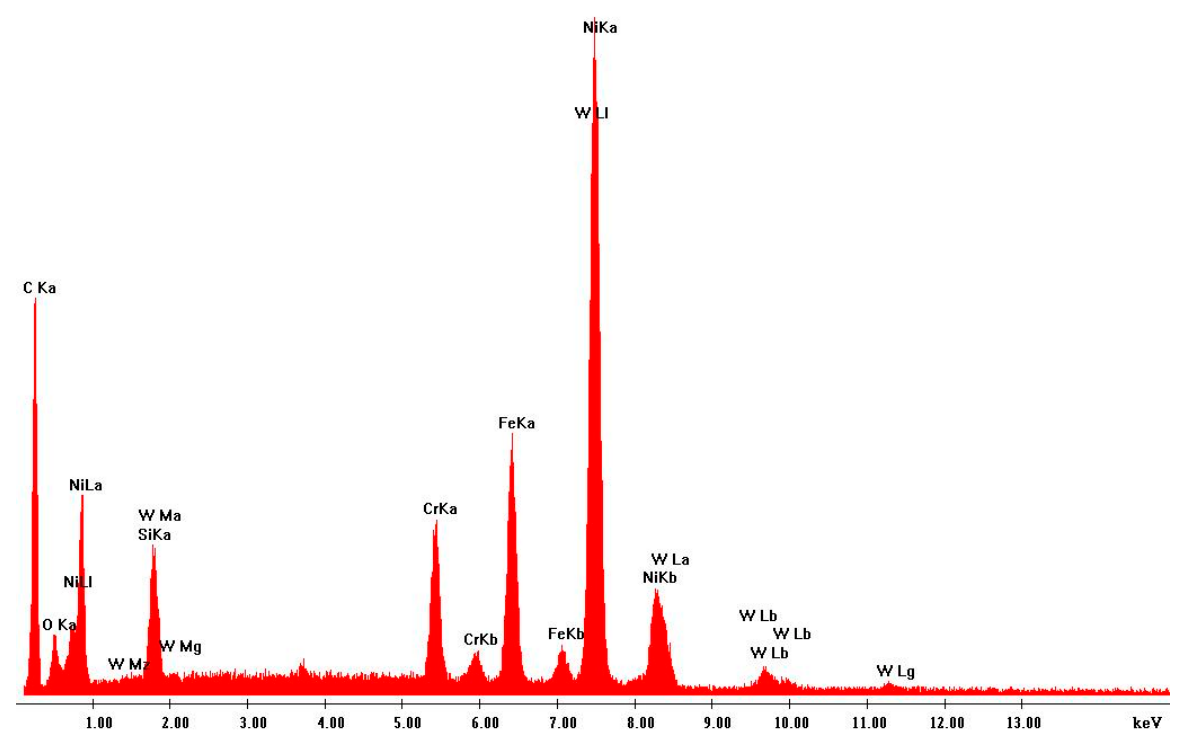
Figure 11. EDS analysis: sample collected during Trial 2 with the tungsten carbide–nickel alloy.